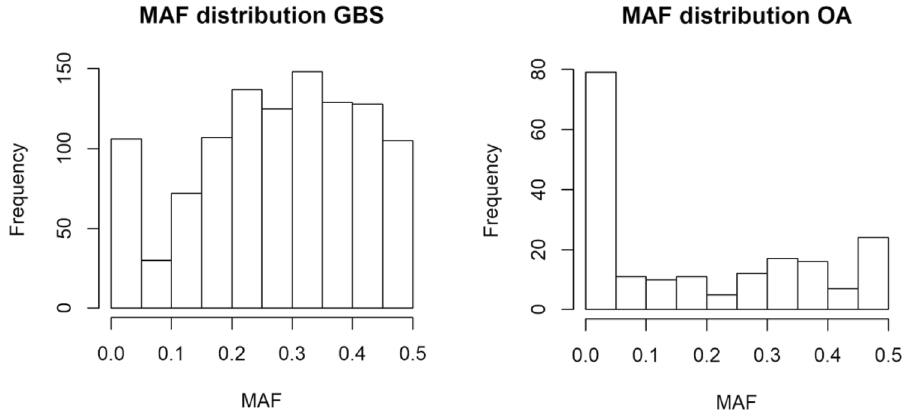
Figure 2. MAF distribution for markers genotyped by Genotyping by Sequencing (obtained from WGS data) or OpenArray (obtained from bibliography and RNAseq